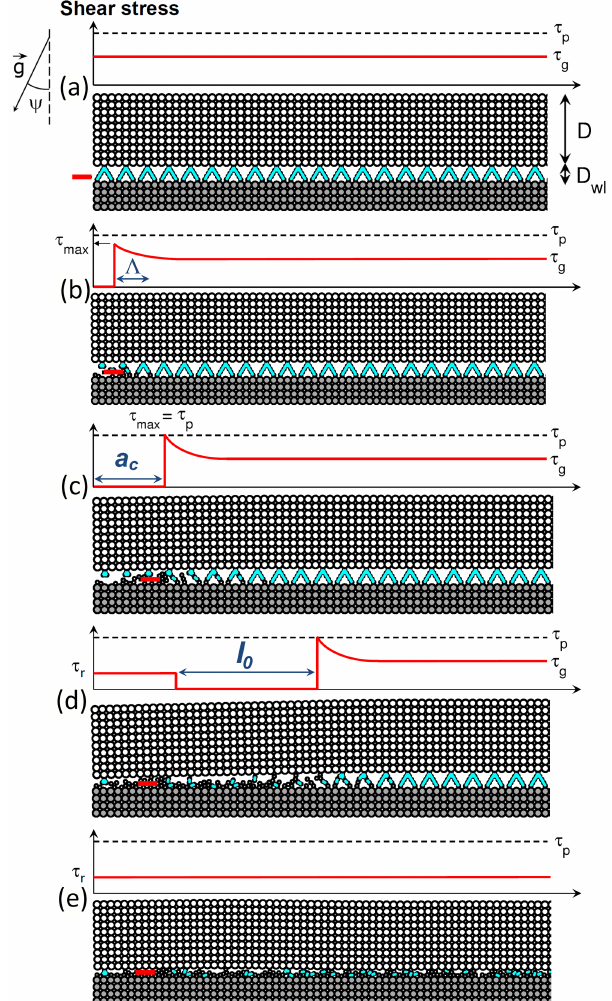
Figure 2. Successive snapshots (a–e) of a DEM simulation of the propagation saw test (PST). The plots on top of each snapshot rep- resent illustrations of the shear stress τ (red line) in the WL. D is the slab thickness (slope normal), D wl is the WL thickness, ψ is the slope angle, τ max is the maximum shear stress at the crack tip, τ p is the WL shear strength (dashed line), τ g = ρgD sin ψ is the shear stress due to the slab weight, and τ r is the residual frictional stress. a c is the critical crack length, (cid:51) is the characteristic length scale of the system, and l 0 is the touchdown length (see Sect. 3). The red segment represents the saw used to cut inside the weak